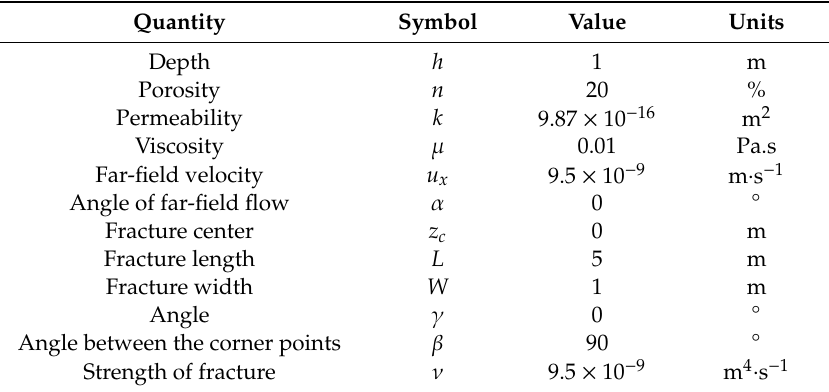
Table A1. Properties for pressure field